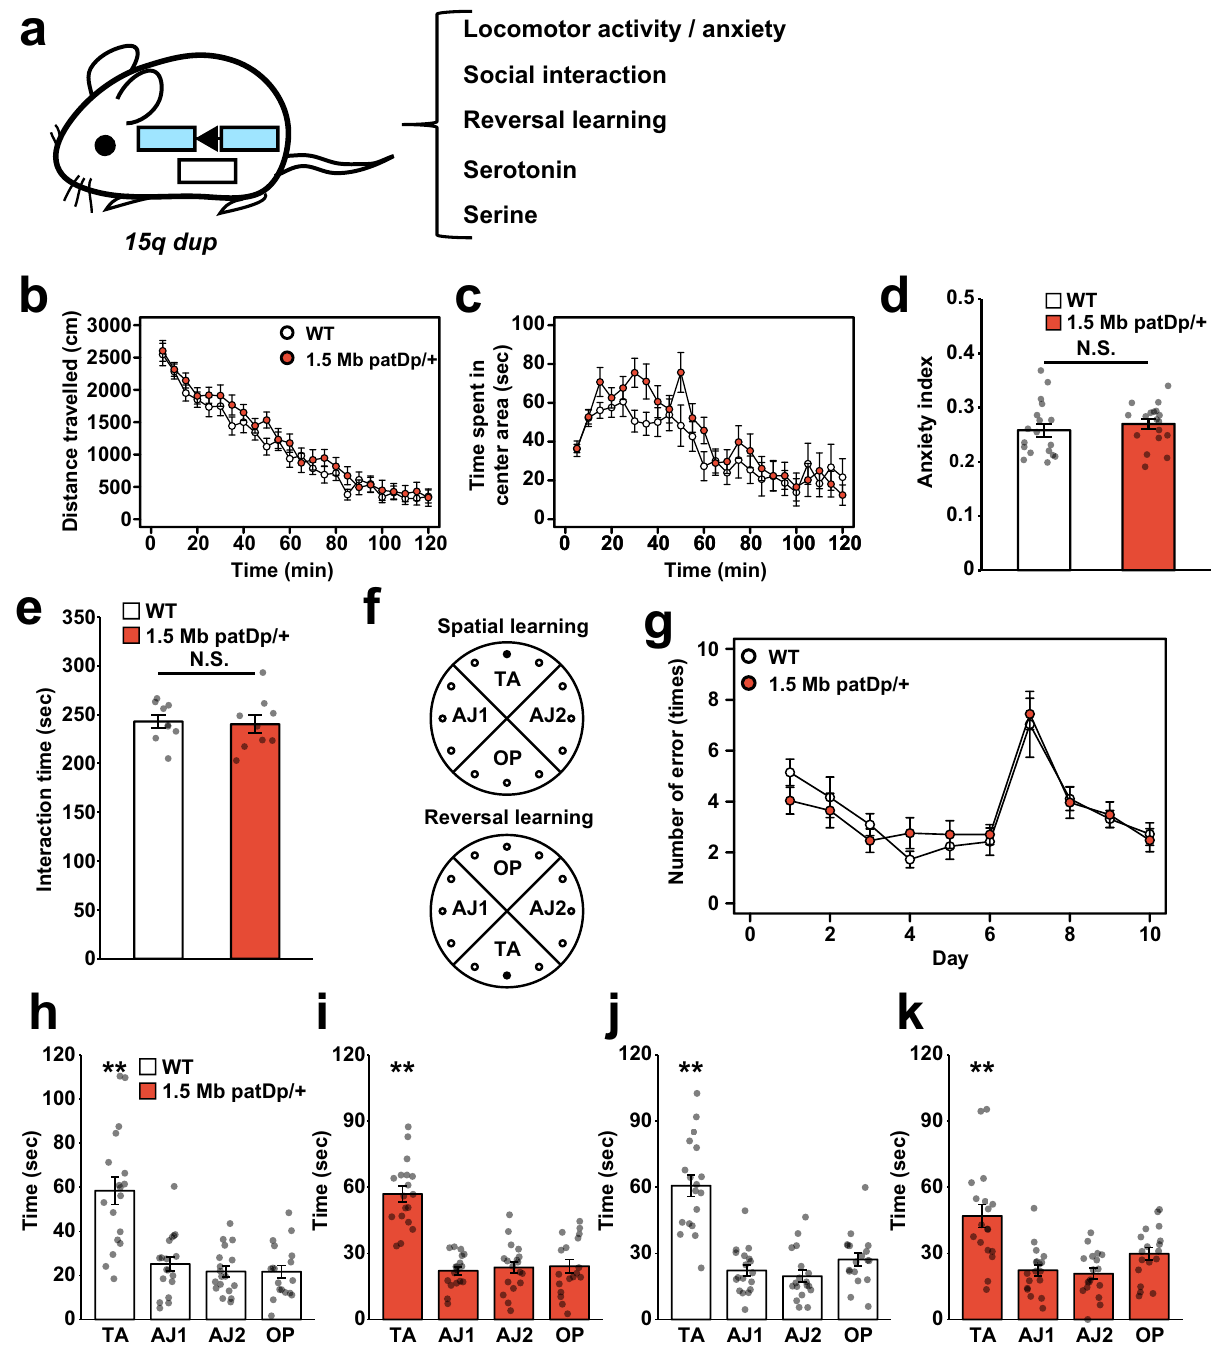
Fig. 2 Paternal duplication mice of 1.5 Mb do not replicate abnormal behaviors found in paternal 15q dup mice. a A schematic of phenotypes of paternal 15q dup mice based on published studies. b – d Open fi eld test in 1.5 Mb patDp/ + mice. Mean values in 5-min segments are plotted including b locomotor activity and c time spent in the center area. d Anxiety index is calculated as distance in the center area divided by total distance during the fi rst 30 min. N = 18 biologically independent mice for each genotype. e Reciprocal social interaction test. The interaction time for each pair of mice is shown. N = 9 pairs of mice for each genotype. f – k Spatial and reversal learning memory was evaluated by the Barnes maze test. f A schematic view of two learning paradigms. TA target quadrant, AJ1/2 adjacent quadrant, OP opposite quadrant. A black fi lled circle indicates the correct hole with an escapable box under the hole. g The number of errors until reaching the correct target is shown. Spatial and reversal learning was conducted on days 1 – 6 and 7 – 10, respectively. Results of probe test on day 6 ( h : WT, i : 1.5 Mb patDp/ + ). WT: TA vs. AJ1/AJ2/OP: p < 0.0001, 1.5 Mb patDp/ + : TA vs. AJ1/AJ2/OP: p < 0.0001. ** p < 0.01 (Dunnett ’ s test). j , k Results of the reversal probe test on day 10. N = 18 biologically independent mice for each genotype. WT: TA vs. AJ1/AJ2/OP: p < 0.0001, 1.5 Mb patDp/ + : TA vs. AJ1/AJ2: p < 0.0001, TA vs. OP: p = 0.0023. ** p < 0.01 (Dunnett ’ s test). Data are represented as mean ± s.e.m. N.S. not statistically signi fi